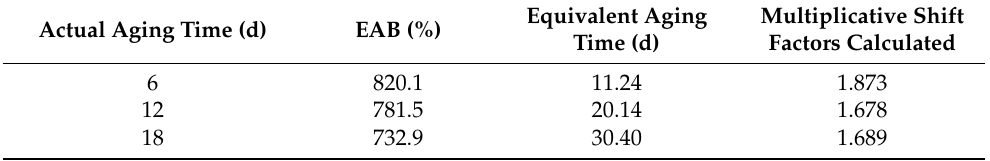
Table 1. Multiplicative shift factor for results of the EAB of the thermal-aged cable insulation at 154 ◦ C. Actual Aging Time (d) EAB (%)